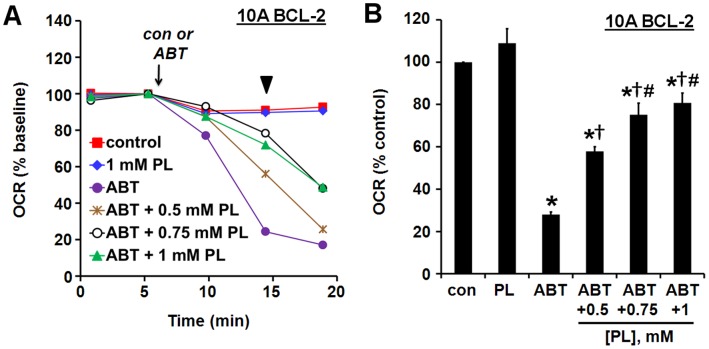
The BAX inhibitor propranolol delays the ABT-737-induced decline in respiration.(A) MCF10A BCL-2 cells were permeabilized as in Figure 5 in the presence or absence of propranolol (PL), and then exposed to ABT-737 (10 µM) or vehicle (con). Results are normalized to OCR just prior to ABT-737 or vehicle addition and are means from one experiment in triplicate. (B) Quantification of the experiment depicted in A. OCR at the second point after ABT-737 or con addition (arrowhead in A) is expressed as a percentage of control (no ABT-737 or PL). Mean ± SE of 3–4 experiments with 2–3 replicates per experiment. *p<0.05 relative to the control treatment; †p<0.05 relative to treatment with ABT-737 alone; #p<0.05 for 0.75 or 1 mM PL+ ABT-737 relative to 0.5 mM PL+ ABT-737.